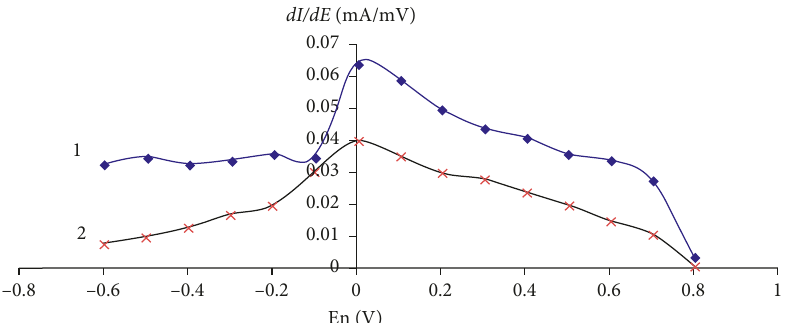
Figure 4: Dependences of the current derivatives of the aflatoxins C background electrolyte is 0.1 N S 6 O 5 P 7 (NH 4 ) 3 ; τ ; � 30 s; w � 30 mV/s; (1) C